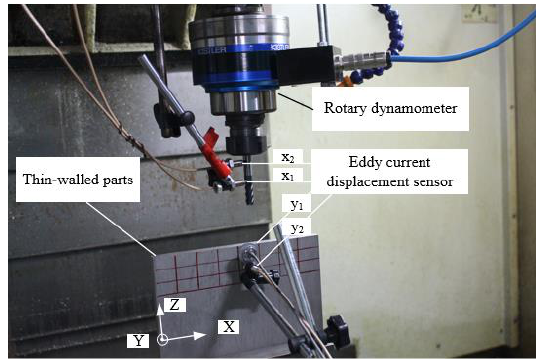
Figure 2. Experimental machining site.